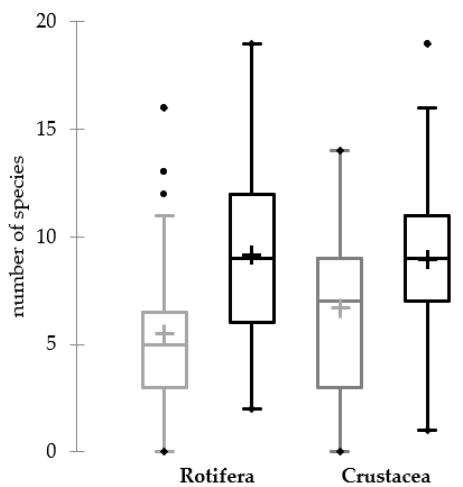
Figure 6. The numbers of rotifers and crustacean species in anoxic (grey outline box) and oxic water layers (black outline box) of lakes with oxygen stress (groups G2 to G6).